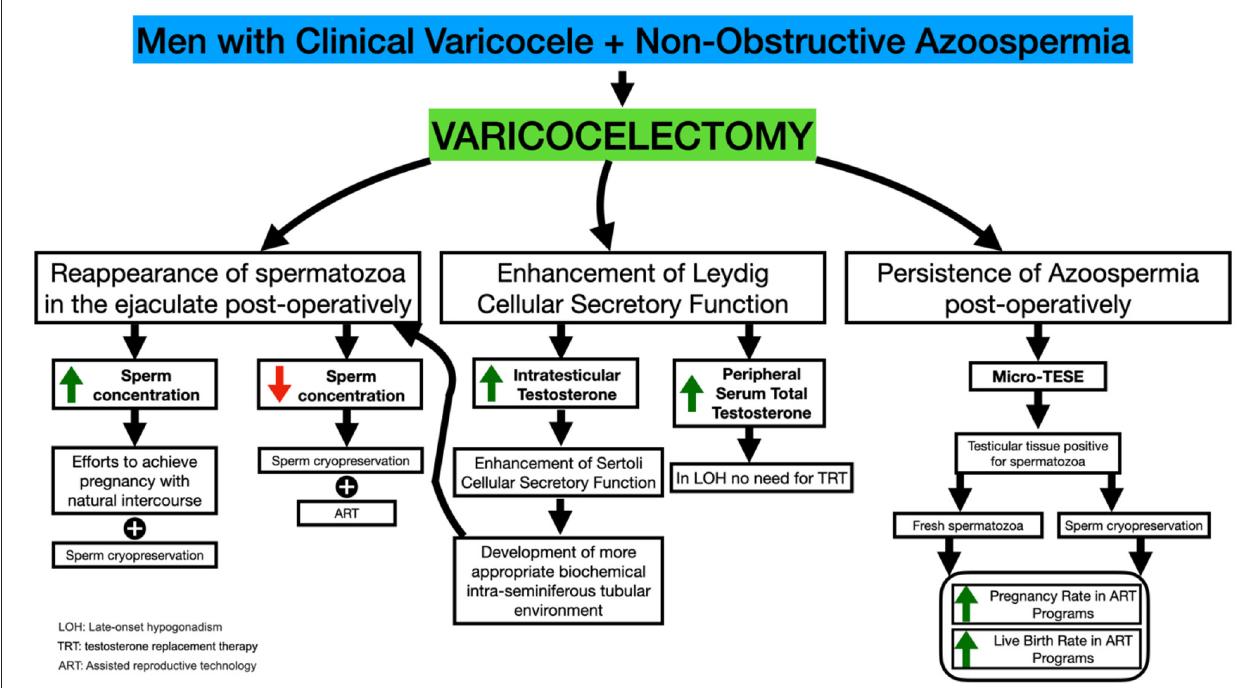
FIGURE 1 | Varicocelectomy in NOA-men: mechanisms modulating the appearance of spermatozoa in the semen, SRRs and ICSI outcome.